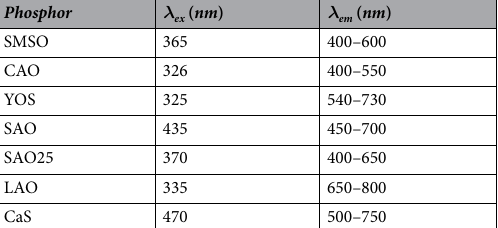
Table 2. Excitation wavelength and integrated emission